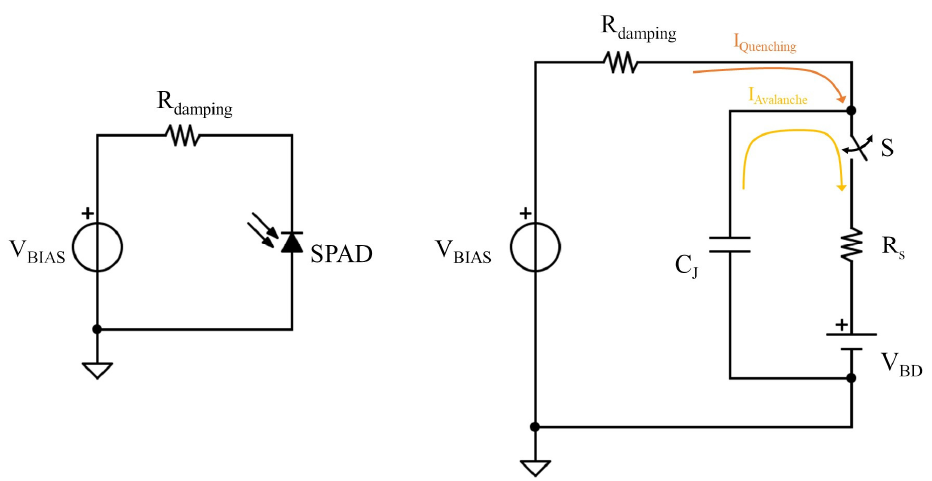
Figure 8. Silicon photomultiplier (SiPM) equivalent circuit.